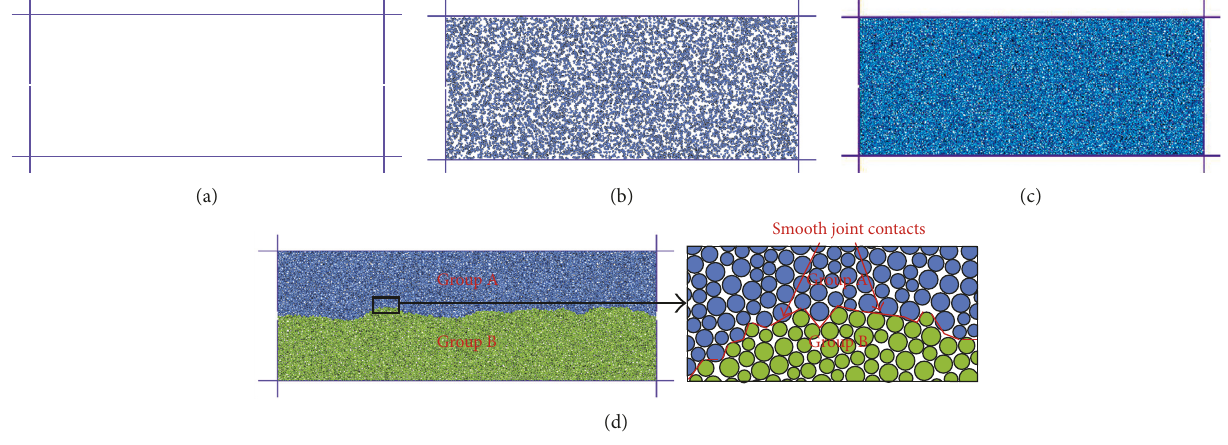
Figure 9: Procedure for generating rock